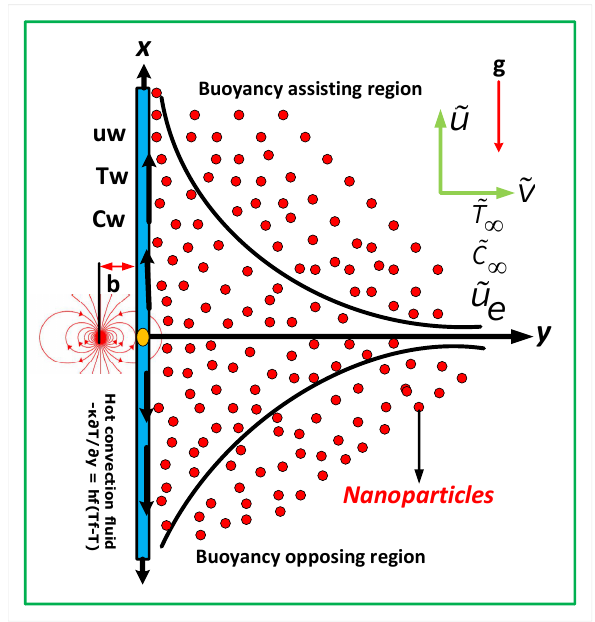
Figure 1. Physical Configuration in